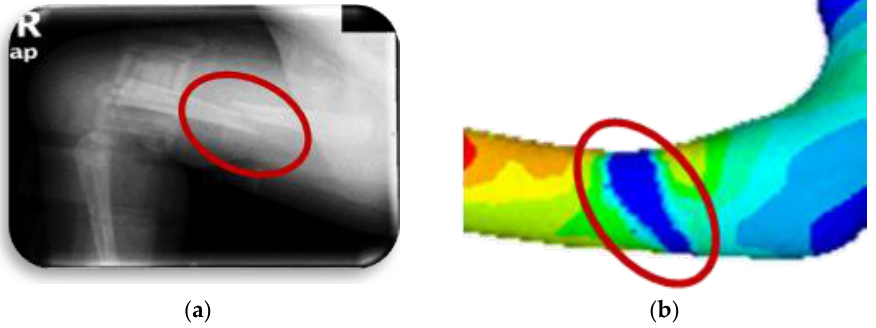
Figure 14. Oblique fracture: ( a ) medical image of bone fracture; ( b ) fracture of finite elements generated on the model.